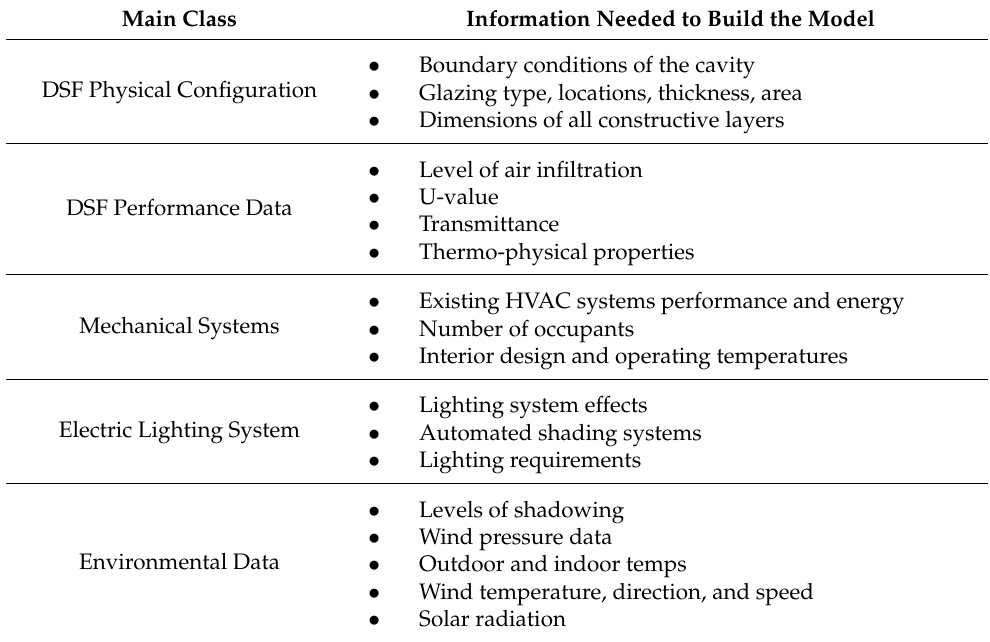
Table 12. Model Parameters to Capture for Energy